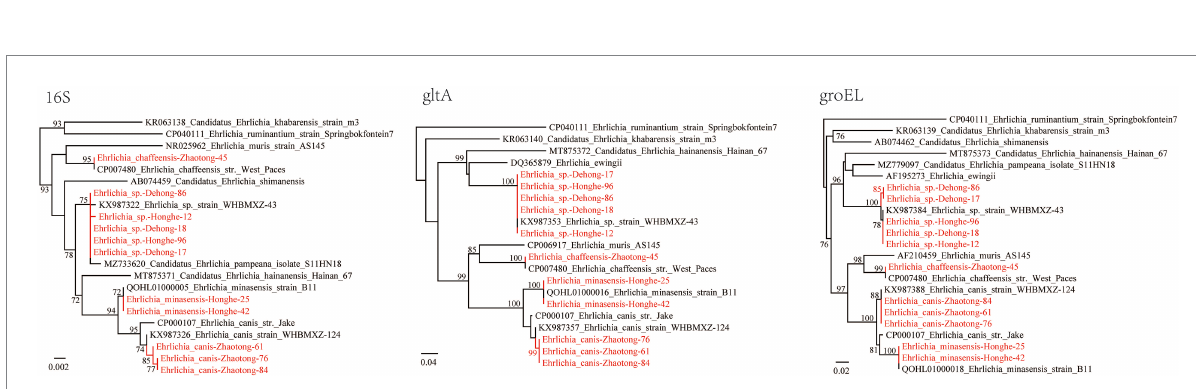
FIGURE 4 Phylogenetic trees constructed by the PhyML 3.0 software based on the nucleotide sequences of 16S rRNA (1,198–1,406 bp), gltA (864–973 bp), and groEL (1,115 bp) genes of Ehrlichia strains. The bootstrap values were shown on the nodes. Red: the strains identified in this